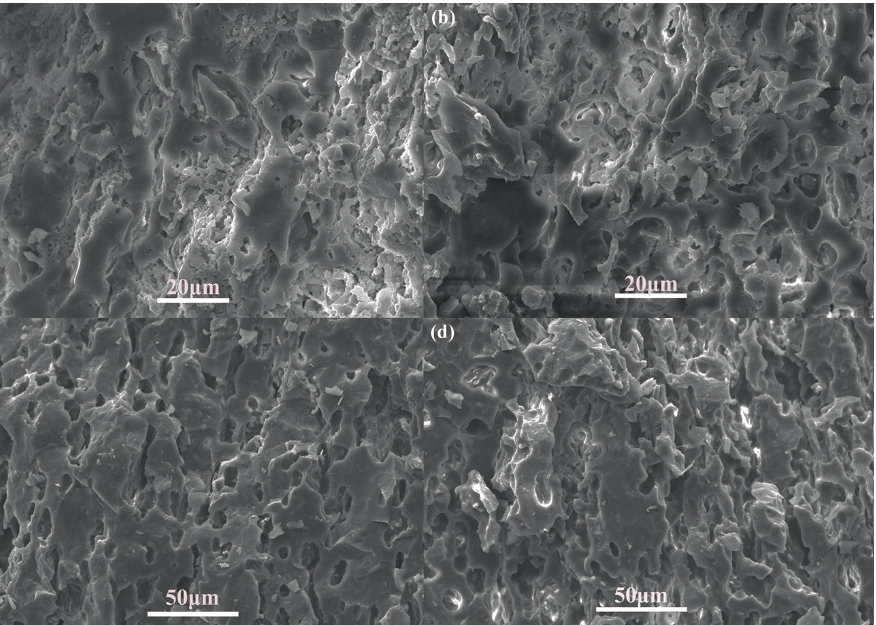
Figure 8: SEM microphotographs of the cordierite-based samples after sintering at 1,200°C ((a) – (b)) and 1,400°C ((c) – (d)) for 2 h with different starch contents: (a) and (c) 5 wt.%; (b) and (d) 20